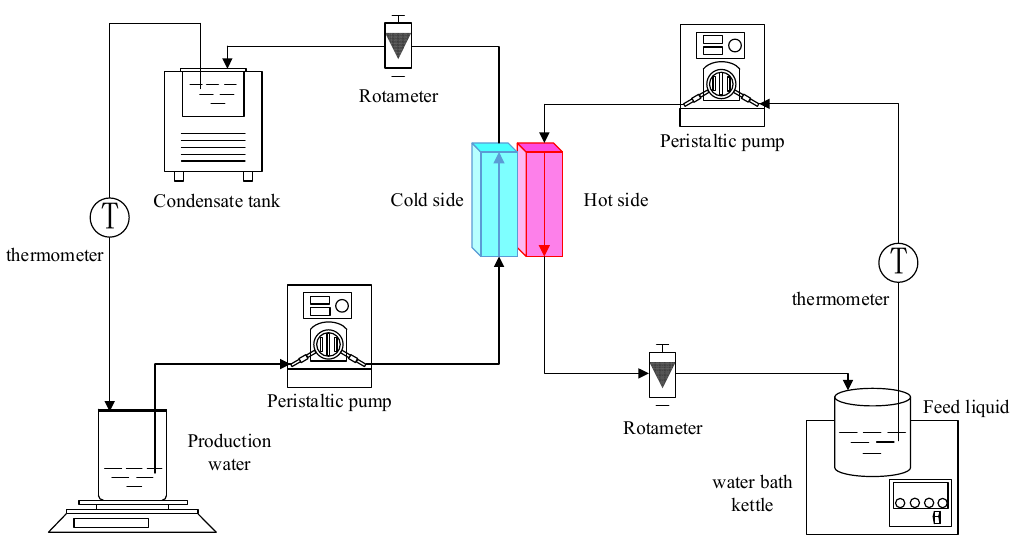
Figure 2. Schematic of the experimental DCMD system.